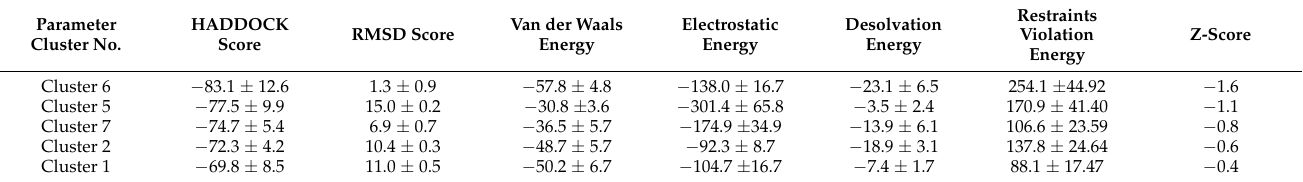
Table 3. Various interaction energy and Binding energies of HIV-1 PR (5KR0) docked with C-PC.